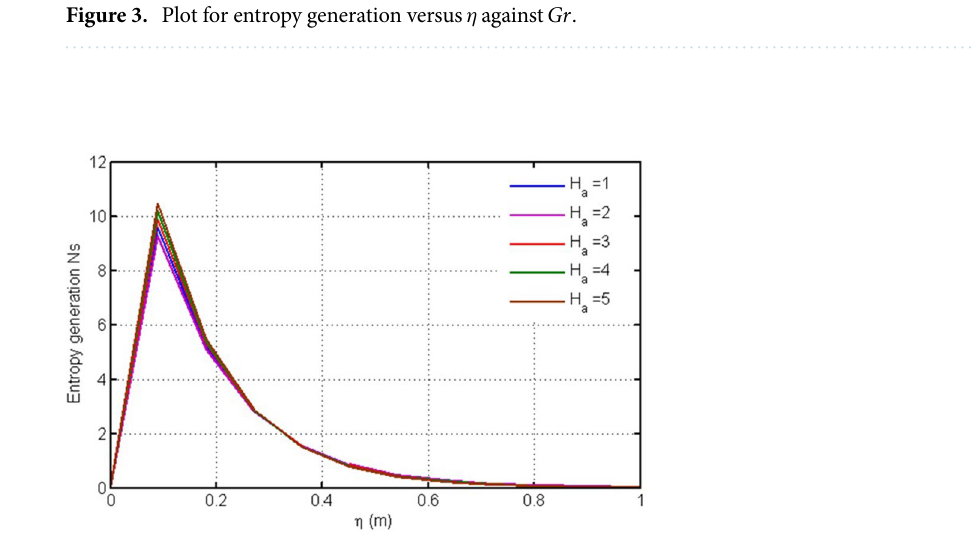
Figure 4. Plot for entropy generation versus η against Ha